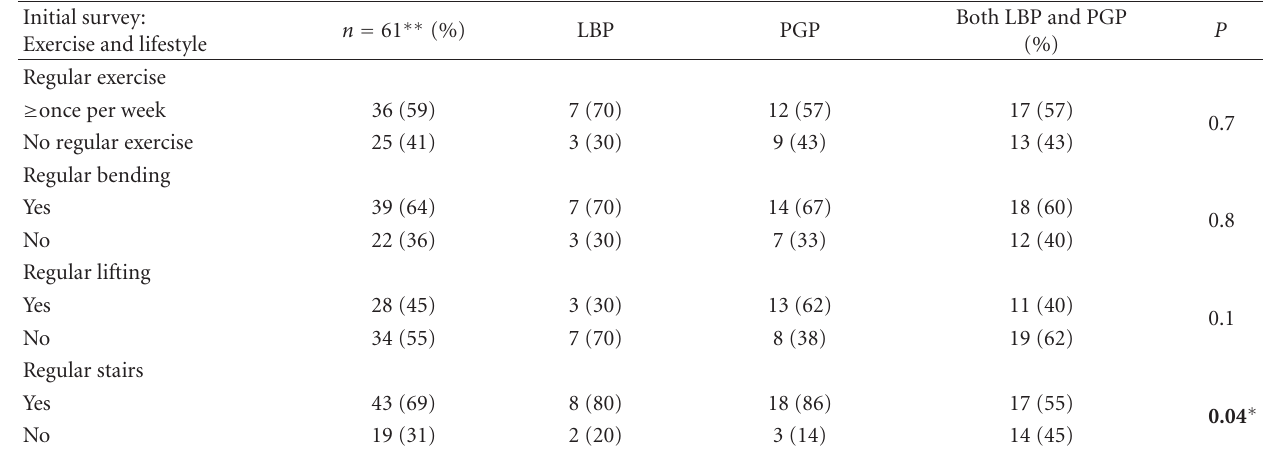
Table 4: LBP, PGP, or combined pain, exercise habits, and lifestyle.